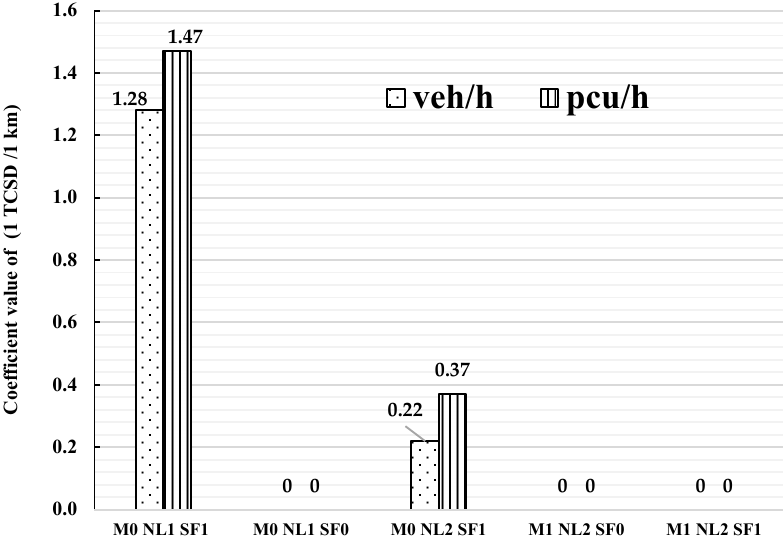
Figure 6. TCSD variation over five developed models.